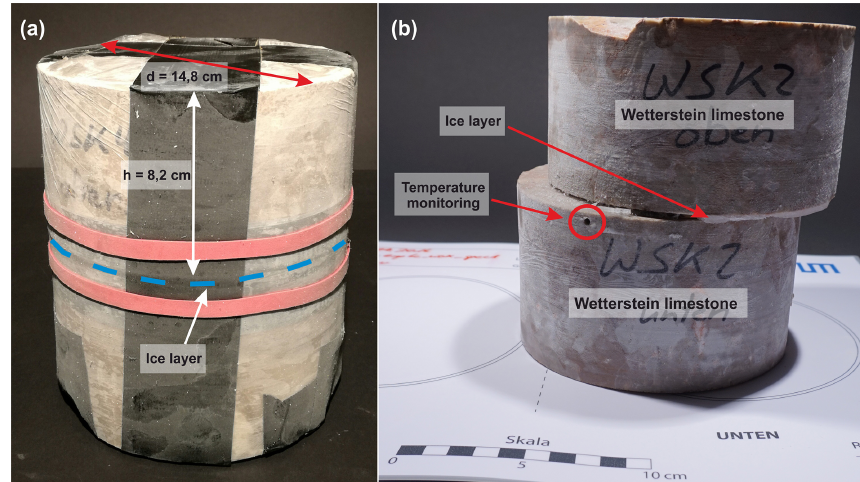
Figure 2. Sandwich sample before (a) and after (b)